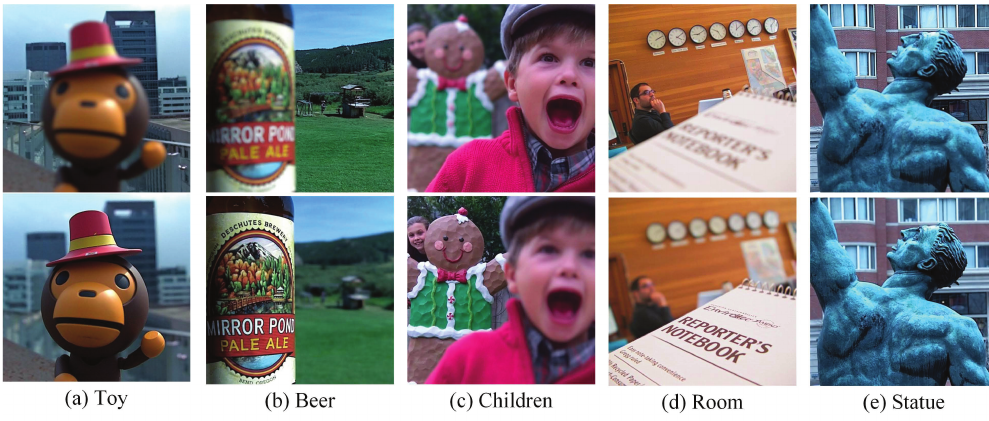
Figure 8. Portion of the test images in the “Lytro”